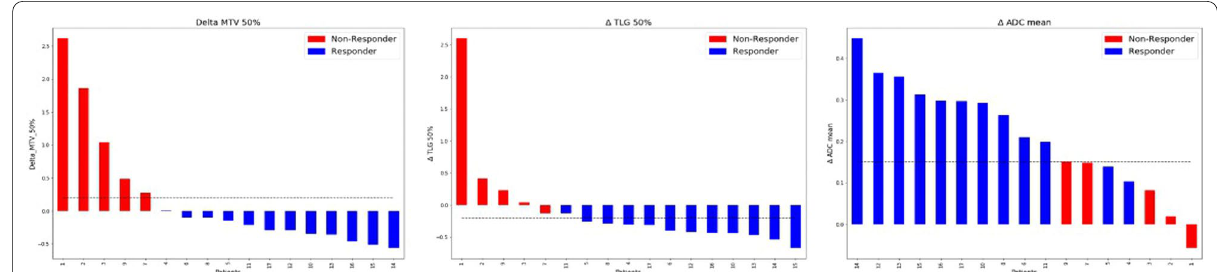
Fig. 2 Waterfall plots demonstrating high sensitivity and specificity in differentiating between chemotherapy responders and non-responders for ∆MTV 50% , ∆TLG 50% , and ∆ADC mean